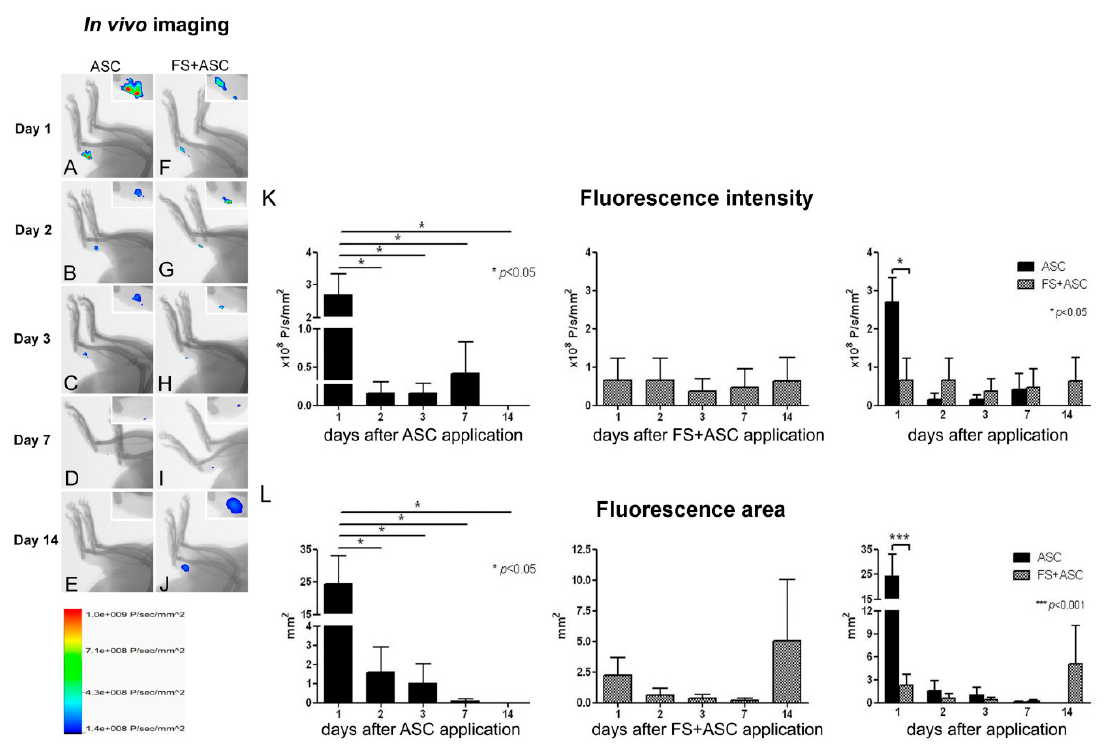
Figure 3. ( A ) In vivo imaging for detection and quantification of PKH26-labeled ASC in the tendon transected region: ASC ( A – E ) and FS + ASC ( F – J ) groups were analyzed on the 1st, 2nd, 3rd, 7th,14th and 21st days after injury ( n = 3). Observe the fluorescence intensity and area in the detail of each image of tendons ( A – J ). Scale: fluorescence intensity ( × 10 8 P / s / mm 2 ). Fluorescence intensity ( K ) and fluorescence area ( L ) occupied by ASC after quantification of images from in vivo imaging. Significant di ff erence represented by (*) and (***) between the ASC and FS + ASC